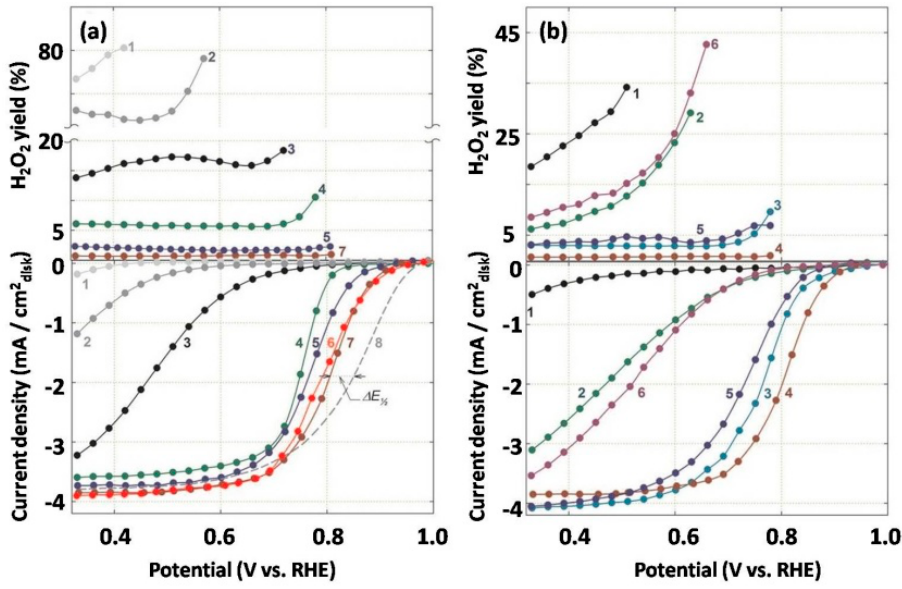
Figure 2. ( a ) Steady-state ORR polarization plots ( bottom ) and H 2 O 2 yield plots ( top ) measured with different PANI-derived catalysts and reference materials: 1, as-received carbon black (Ketjenblack EC-300J); 2, heat-treated carbon black; 3, heat-treated PANI-C; 4, PANI-Co-C; 5, PANI-FeCo-C(1); 6, PANI-FeCo-C(2); 7, PANIFe-C; and 8, E-TEK Pt/C (20 μ g Pt cm −2 ). Electrolyte: O 2 -saturated 0.5 M H 2 SO 4 (0.1 M HClO 4 in